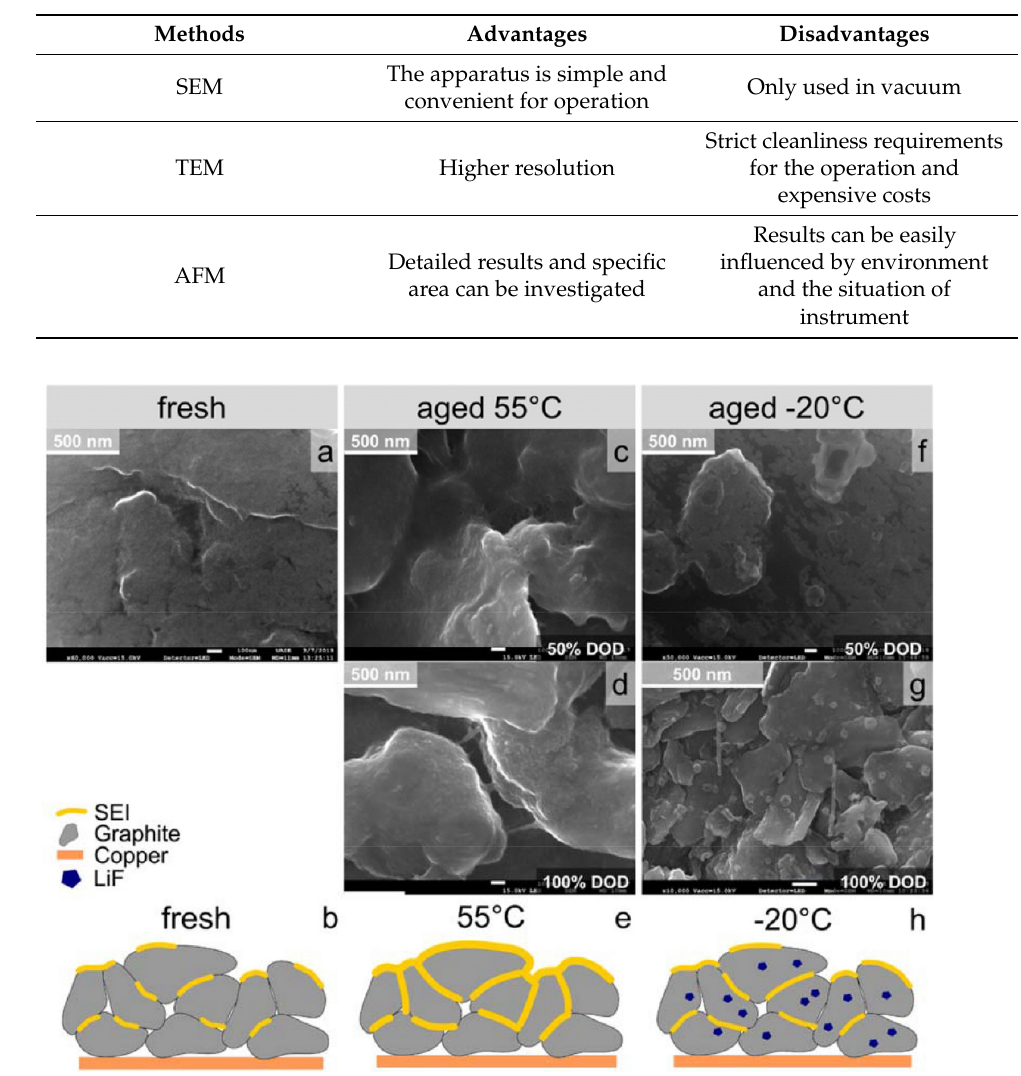
Table 4. Comparison of different morphology characterization methods.